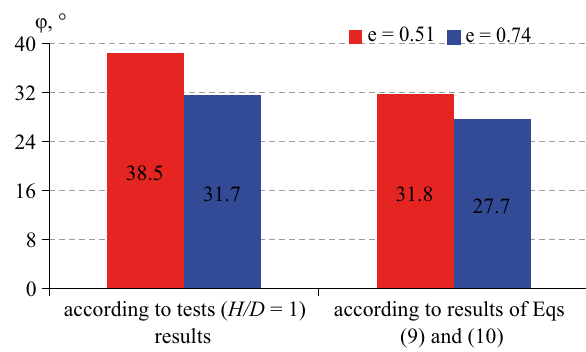
Fig. 16. Values of angle of internal friction φ